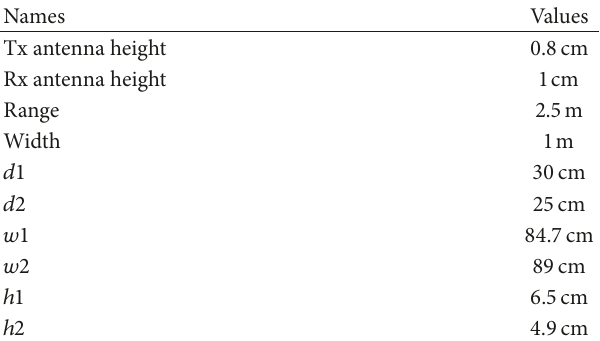
Table 2: Parameters of knife edge propagation.